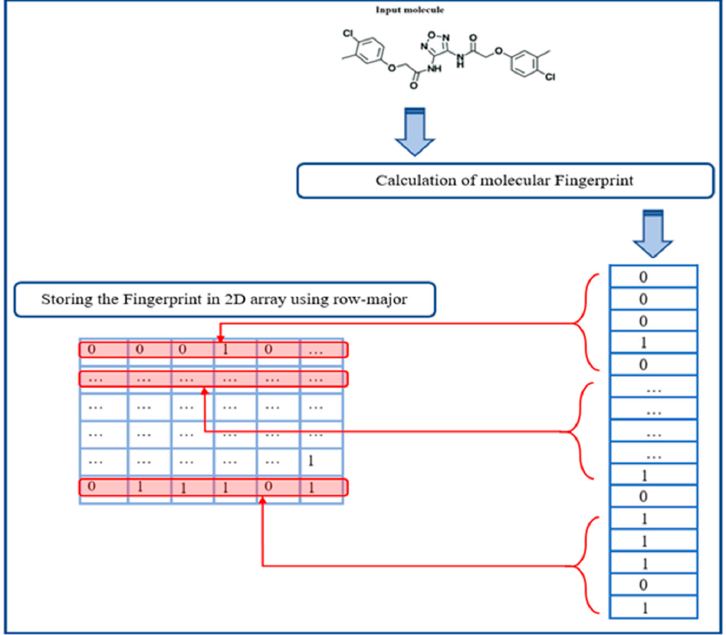
Figure 17. A summary of the newly proposed Mol2mat presentation process.